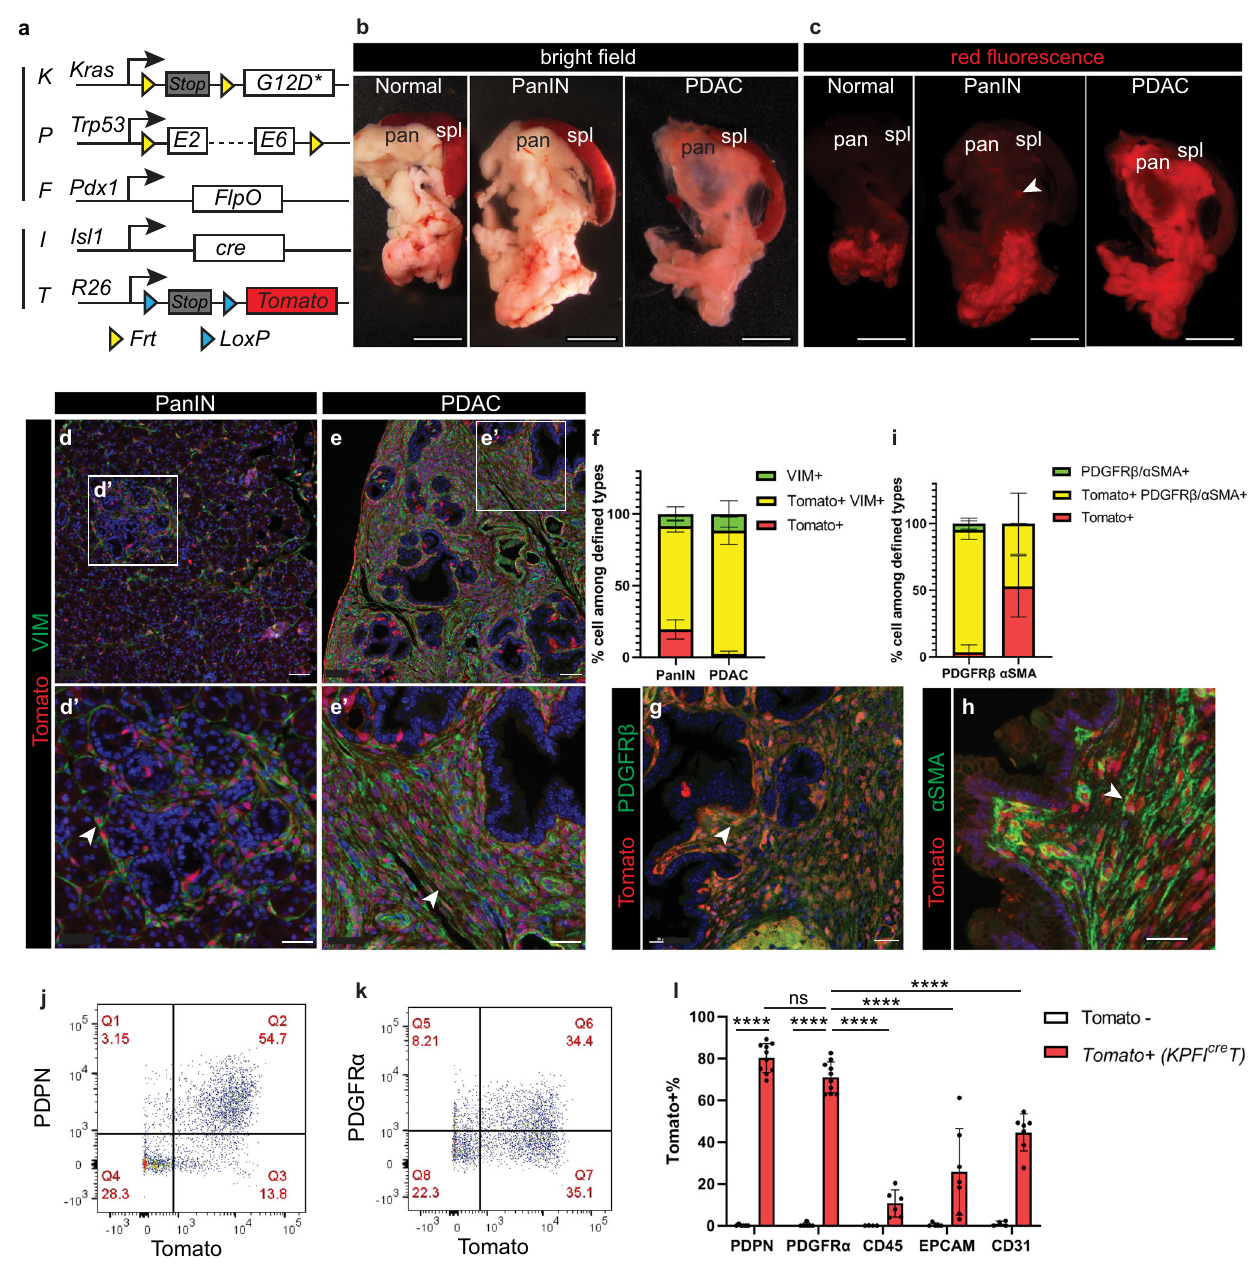
Fig.3|Themajorityofpancreaticcancer-associated fi broblastsaretargetedin theKPFI cre T model. a Schematicof the KPFI cre T mouse model. b , c Bright fi eld and red epi fl uorescence views of dissected pancreata and spleens. Normal, n =3 mice; PanIN, n =6 mice; PDAC, n =3 mice. Arrowhead denotes a puncta of red fl uores- cence. d – f Co-immunostainingonpancreatictissuesandquanti fi cationofcellsthat are either single positive ordouble positive for de fi ned markers. PanIN, n =4mice; PDAC, n =5 mice. g – I Co-immunostaining on pancreatic tissues and quanti fi cation of cells that are either single positive or double positive for de fi ned